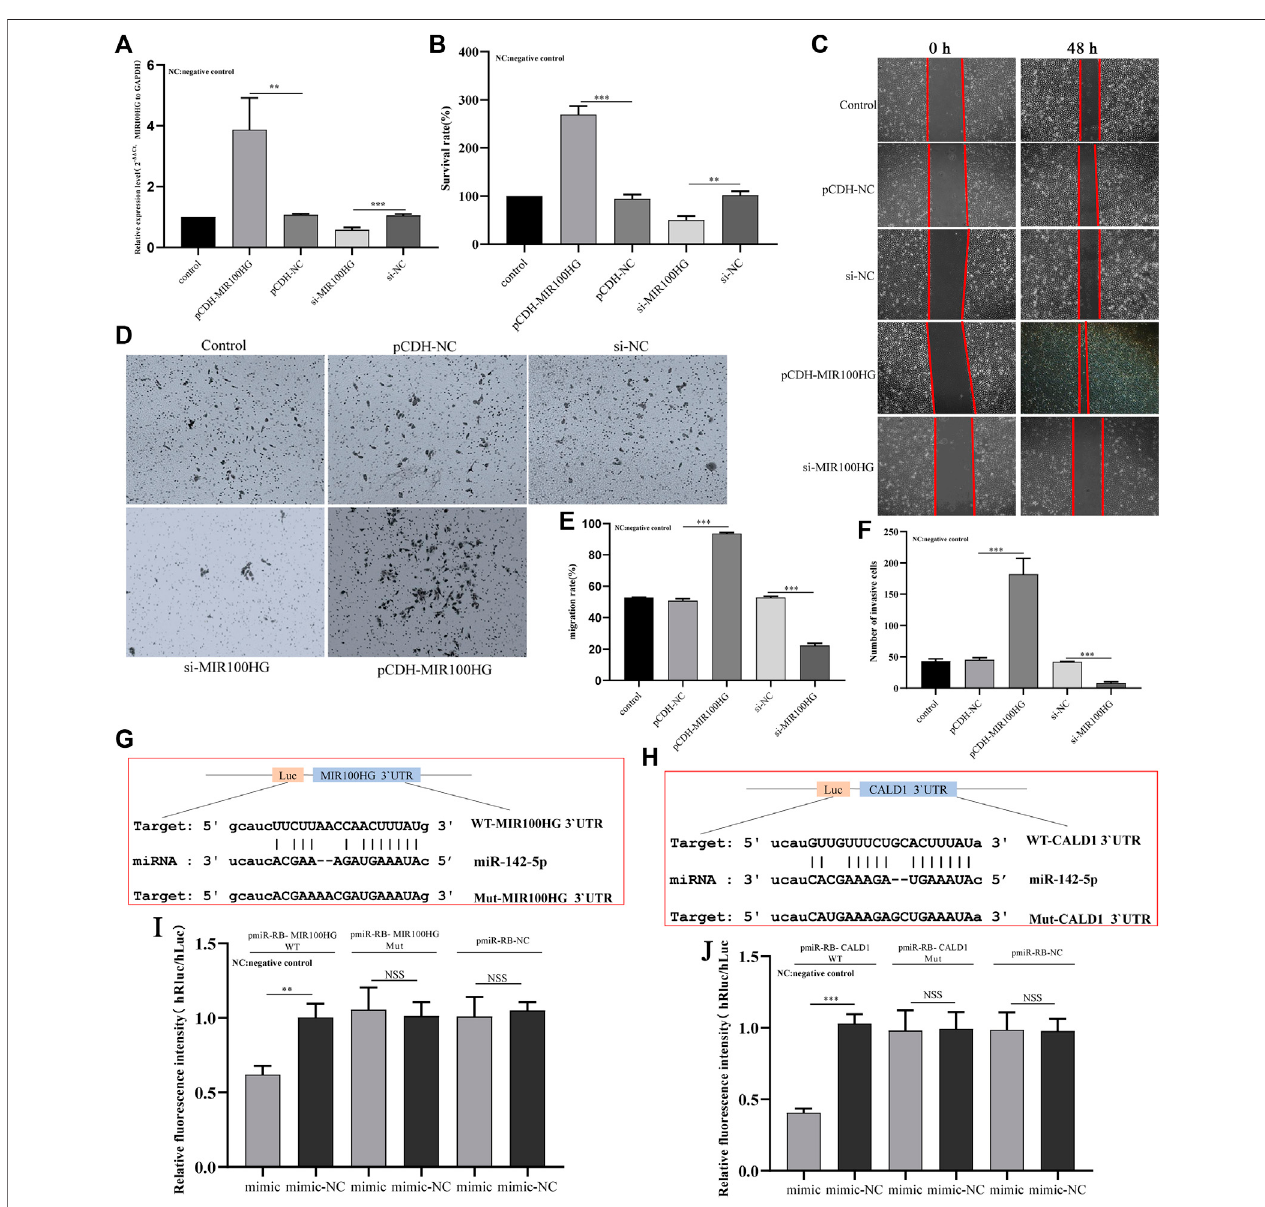
FIGURE 8 | (A) Analysis of the effects of MIR100HG knockdown or overexpression on 5,637 cells using qPCR. The expression level of GAPDH was used as an internalreference. (B) Analysisoftheeffects ofMIR100HGknockdown oroverexpressionon theproliferationof5,637 cellsusing theCCK-8assay. (C,E) Analysisofthe effects of MIR100HG knockdown or overexpression on the migration of 5,637 cells using the wound healing assay. (D,F) Analysis of the effects of MIR100HG knockdown or overexpression on the invasion of 5,637 cells using transwell assays. (G) Sequence of miR-142-5p and MIR100HG 3 ′ UTR binding sites. (H) SequenceofmiR-142-5pandCALD13 ′ UTRbindingsites. (I) ResultsofthedualluciferaseassayformiR-142-5pandMIR100HG. (J) Resultsofthedualluciferaseassay for miR-142-5p and CALD1. NC stands for negative control. pCDH-NC represents negative plasmid of pCDH- vector, and has no effect on cell biological function after transfection. Si-NC represents the negative control of si-RNA, which has no effect on cell biological function after transfection. “ Control ” refers to the cell group without any plasmid transfection, which is only used as a reference for the analysis of the experimental group. The data are shown as the mean ± standard deviation. WT: wild type. Mut: mutant type. Luc: Luciferase. “ *** ” p -value < 0.001, “ ** ” p -value < 0.01, “ NSS ” : no statistical signi fi